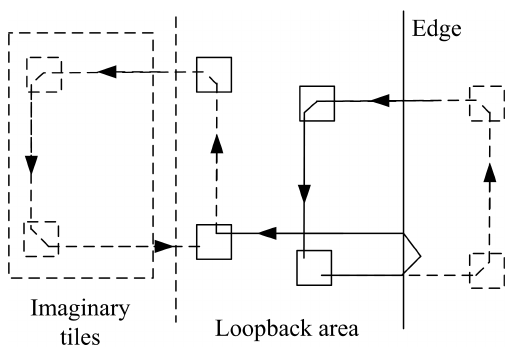
Figure 12. Partial-cascade structure in the loop-back area.